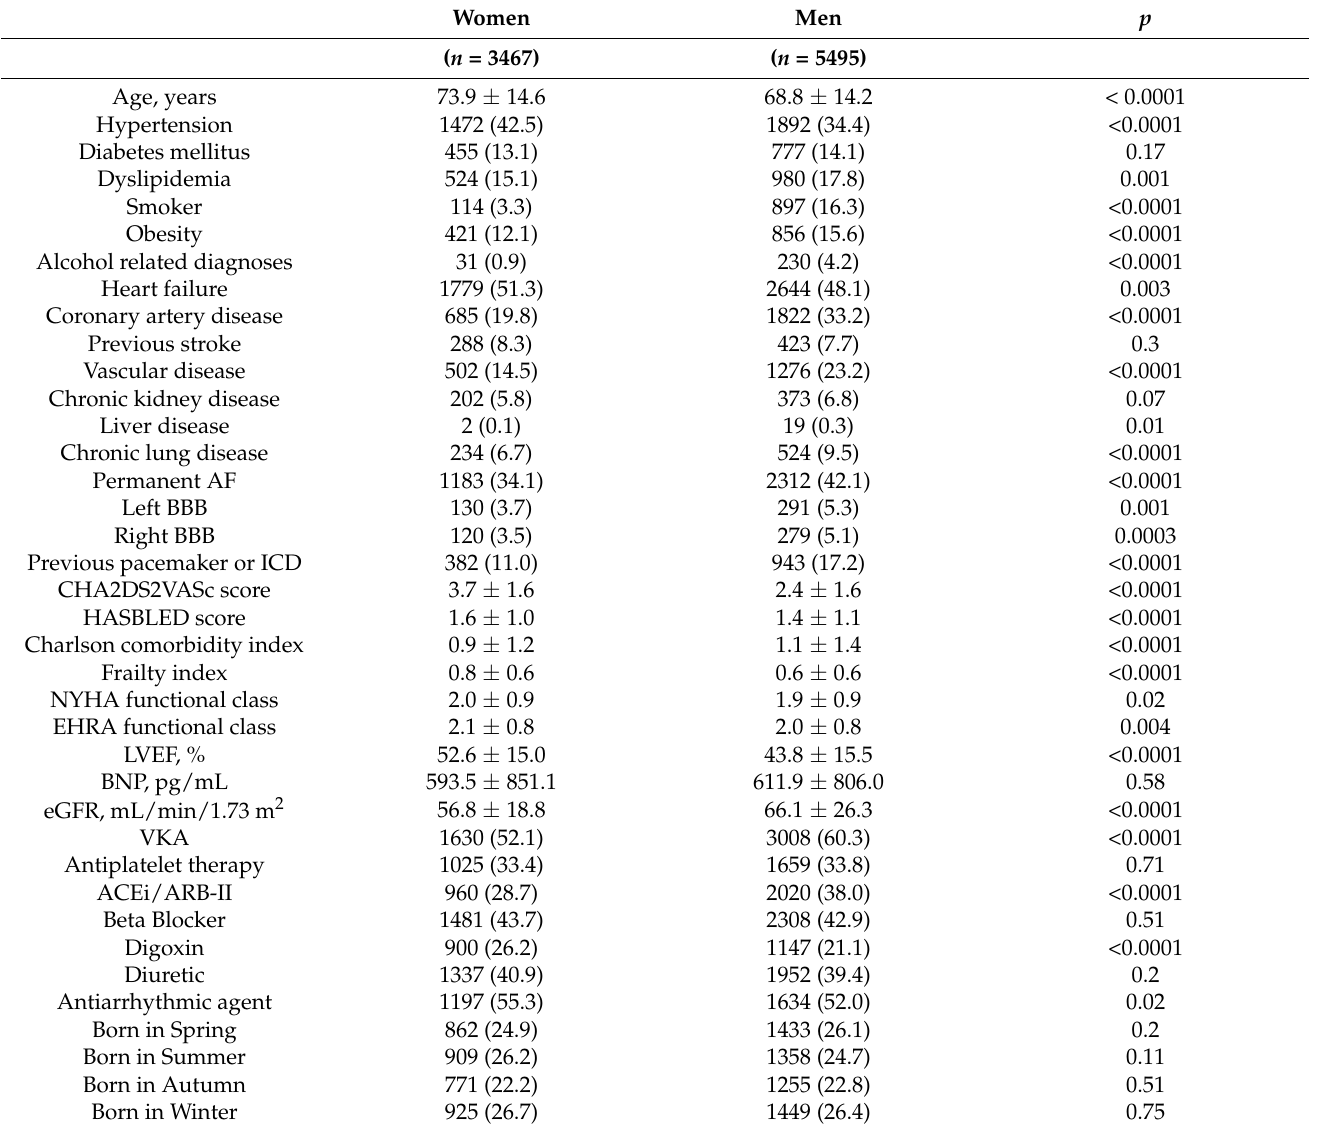
Table 2. Baseline characteristics of patients with AF according to